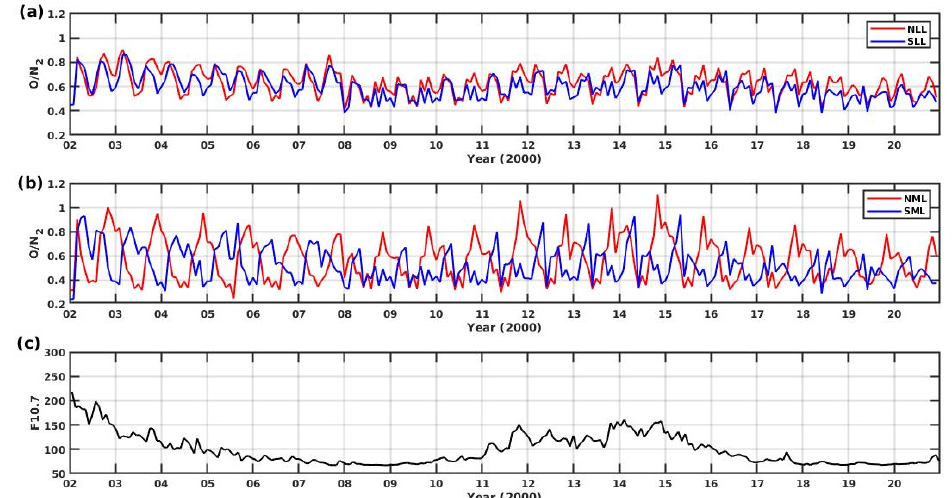
Figure 1. ( a ) Monthly averaged O/N 2 variations in both hemispheres for low-latitudes. ( b ) Monthly mean O/N 2 variations in both hemispheres for mid-latitudes. ( c ) Solar index F10.7 variations during the SC 24.